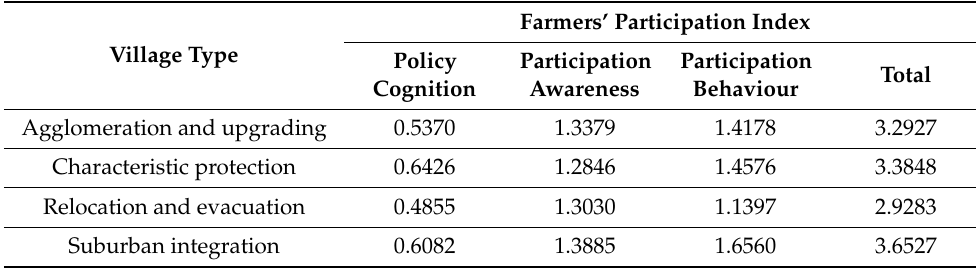
Table 8. Farmers’ participation index in rural settlement environment improvement by village type.